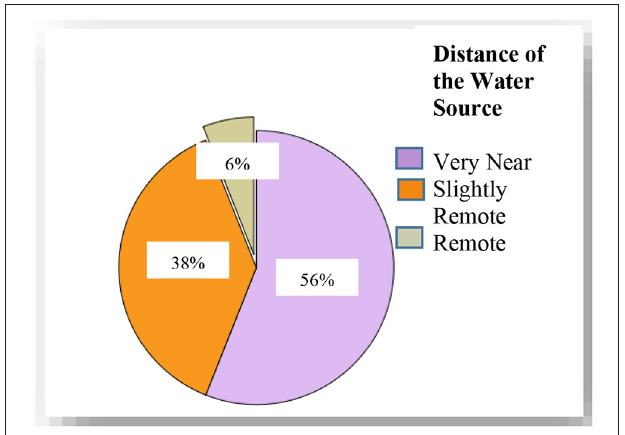
FIGURE 8 | Water use pattern.